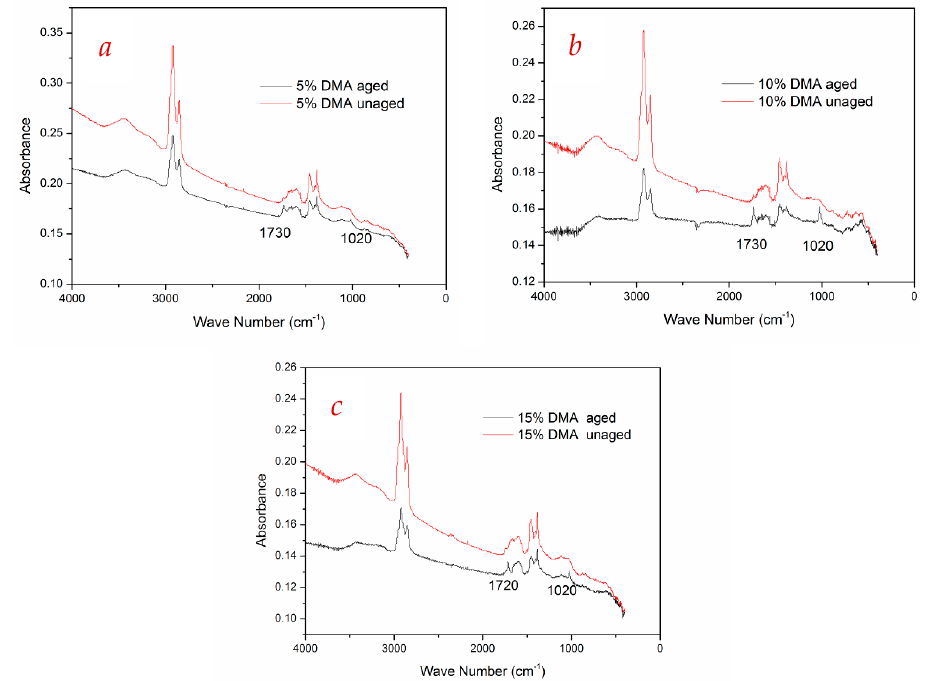
Figure 5. FTIR spectra of DMA. ( a ) 5% DMA; ( b ) 10% DMA; ( c ) 15% DMA.